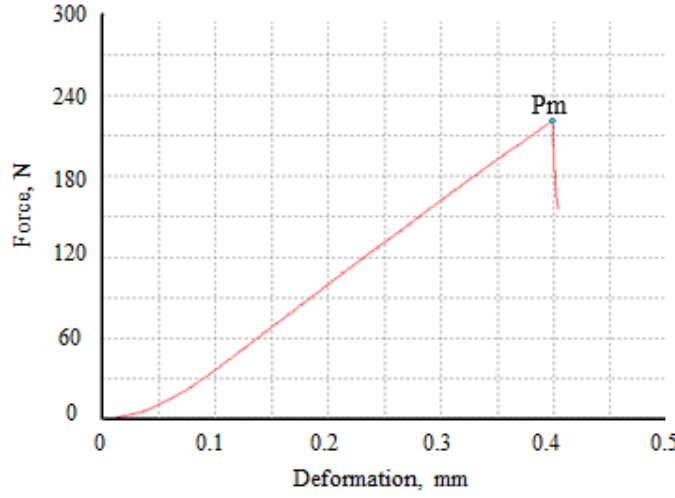
Figure 2. The force–deformation relationship of SN42 soybean seeds. In our study, the deformation caused by collision during particle movement were within a small range of changes (0.01–0.05 mm) [21]. Therefore, the second section of the curve in the range of smaller deformations was analyzed and processed in this paper. This segment of data was processed in an Excel sheet and a straight line was fitted, as shown in Figure 3. The slope of this straight line is the stiffness coefficient of the soybean seed particles.